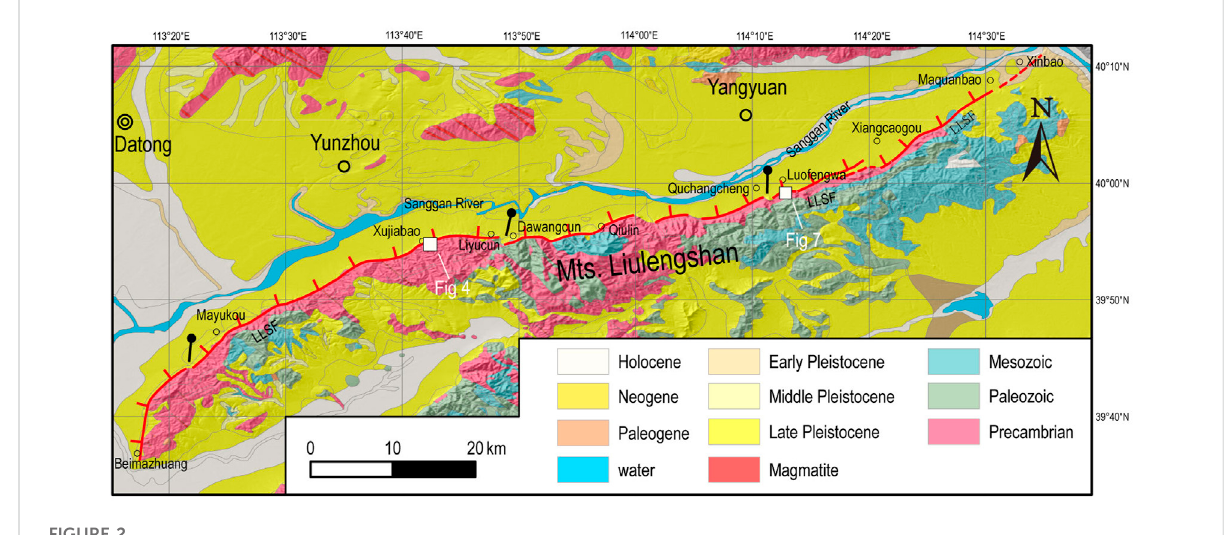
FIGURE 2 Tectonic outline of the study area. The red lines mark normal faults. Stratigraphic data from Shanxi provincial Geological Exploration Bureau (1975) and fi eld work. The black point with line represents the fault ’ s segmentation